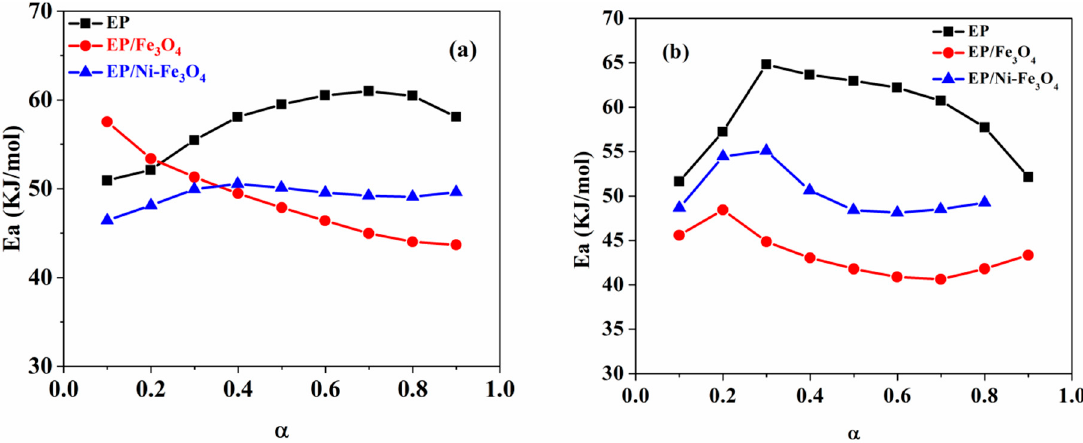
Figure 5. Variation of activation energy with conversion for EP, EP-Fe 3 O 4 [22,29] and EP-Ni/Fe 3 O 4 nanocomposites estimated by the ( a ) differential Friedman model and ( b ) integral Kissinger–Akahira–Sunose (KAS) model.